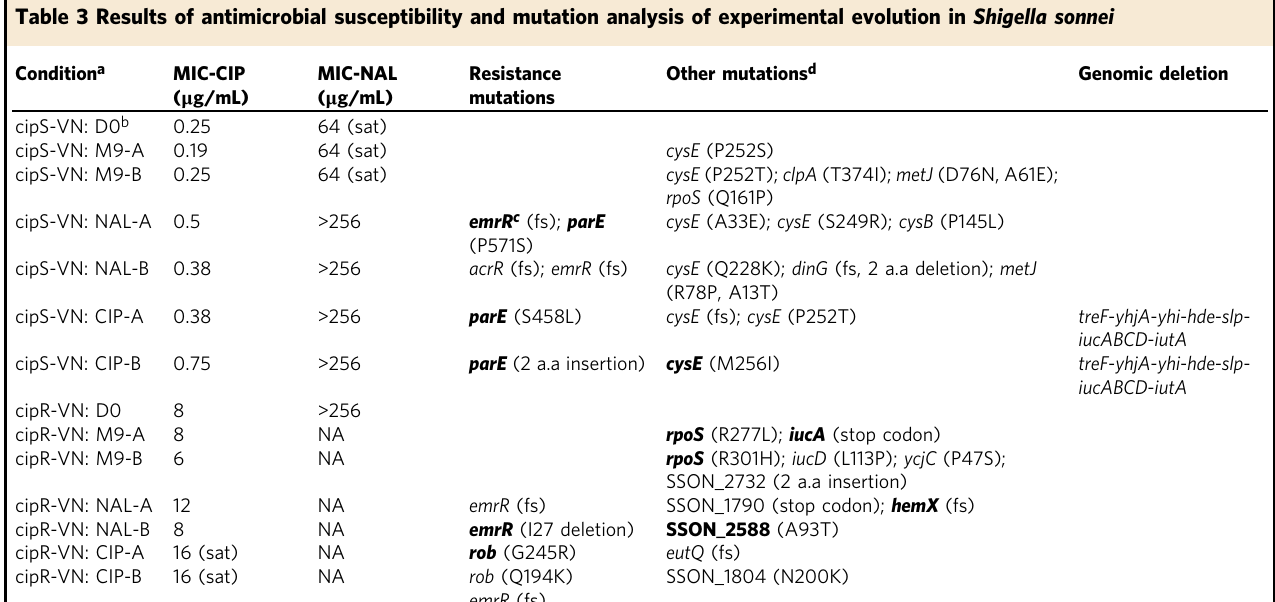
to disruptive mutations in the transcriptional repressor, emrR .